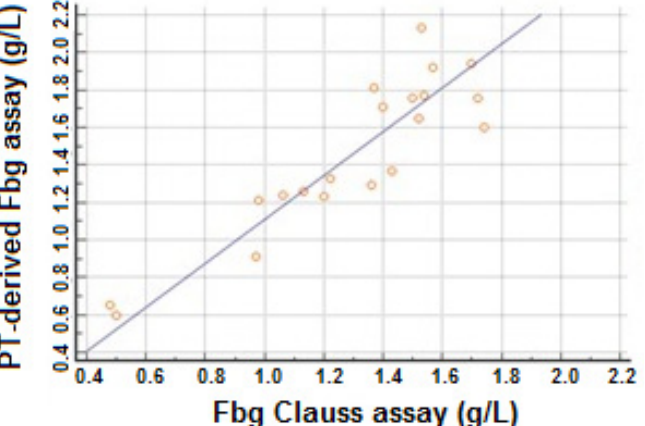
Figure 3. Linear correlation (r = 0.9016; p < 0.0001) between PT-derived fibrinogen and fibrinogen Clauss assay in patients with hypofibrinogenemia according to the study published by Skornova et al. between coagulation factor activity level and clinical bleeding phenotype